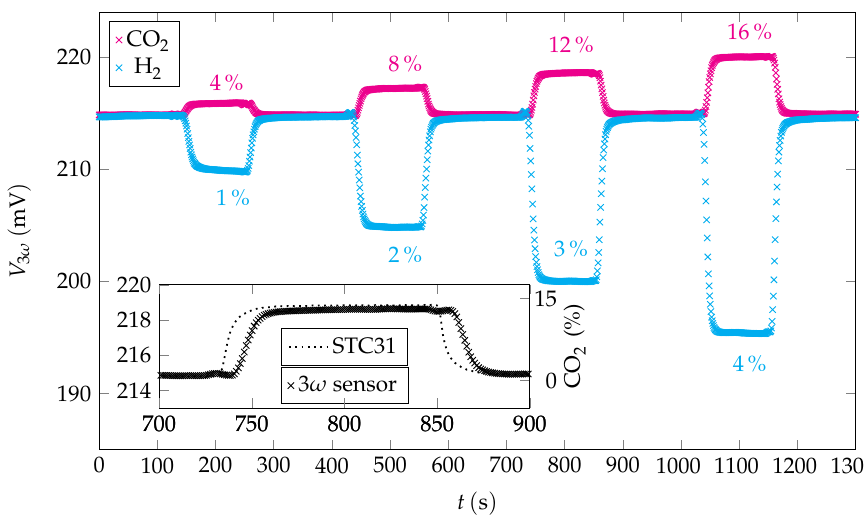
Figure 9. Different H 2 and CO 2 concentrations vs. time. Due to the lower limit of the MFCs, the concentrations had to be increased with respect to the concentrations measured before. CO 2 causes a reduction of the thermal conductivity and therefore results in a higher output signal, whereas H 2 has the contrary behaviour. The inbox plot shows an exemplary comparison of the signal of our sensor to the output of an STC31 reference sensor at 12% CO 2 in N 2 . The response time of the 3 ω sensor is about 10s delayed with respect to the reference sensor.